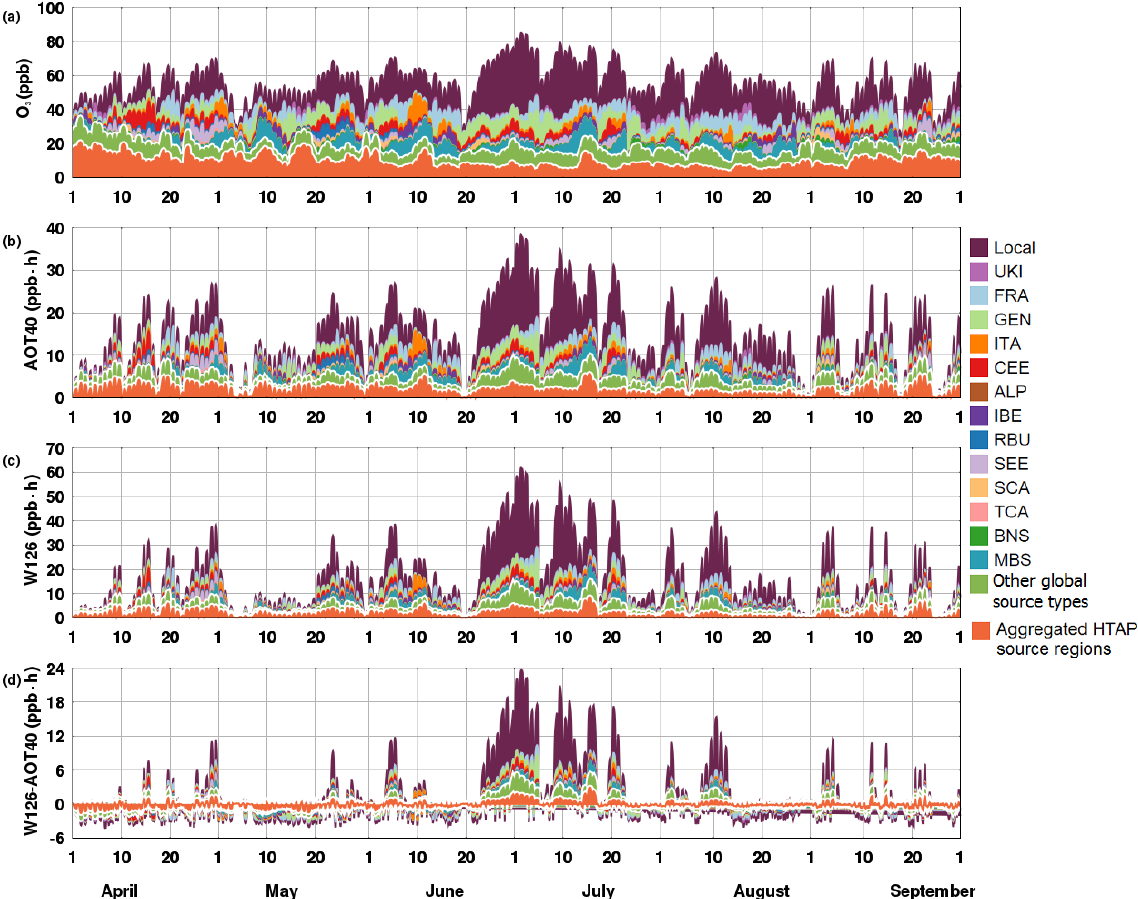
Figure 8. April–September 2010 time series of daytime (a) hourly O 3 (ppb), (b) hourly AOT40 index (ppb · h), (c) hourly W126 index (ppb · h), and (d) differences between W126 and AOT40 indexes (ppb · h) averaged over the Po Valley receptor region. The colour bars indicate the O 3 source categories – aggregated HTAP2 regions (ASI, NAM, NAF, OCN, and RST), the other global source types (STR, LGT, BMB, and BIO), and the European source regions. The white dashed lines in each panel separate different categories (intercontinental transport, other global source types, and local and other European